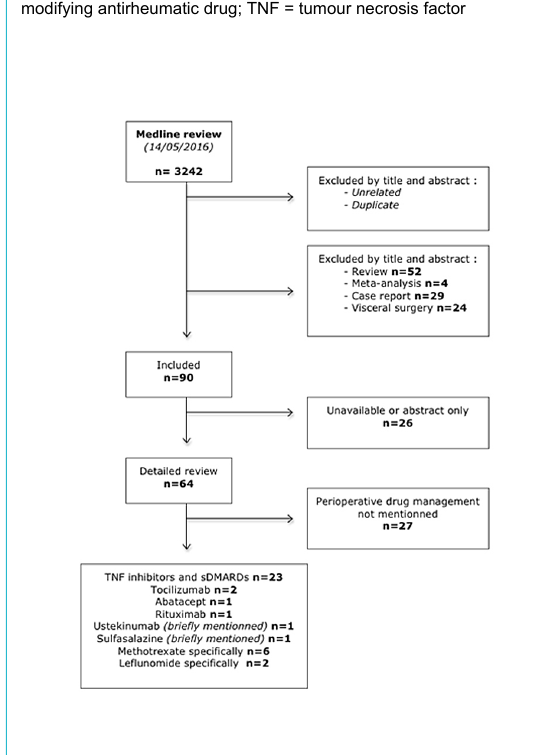
Figure 1: Medline search strategy.sDMARD = synthetic disease modifying antirheumatic drug; TNF = tumour necrosis